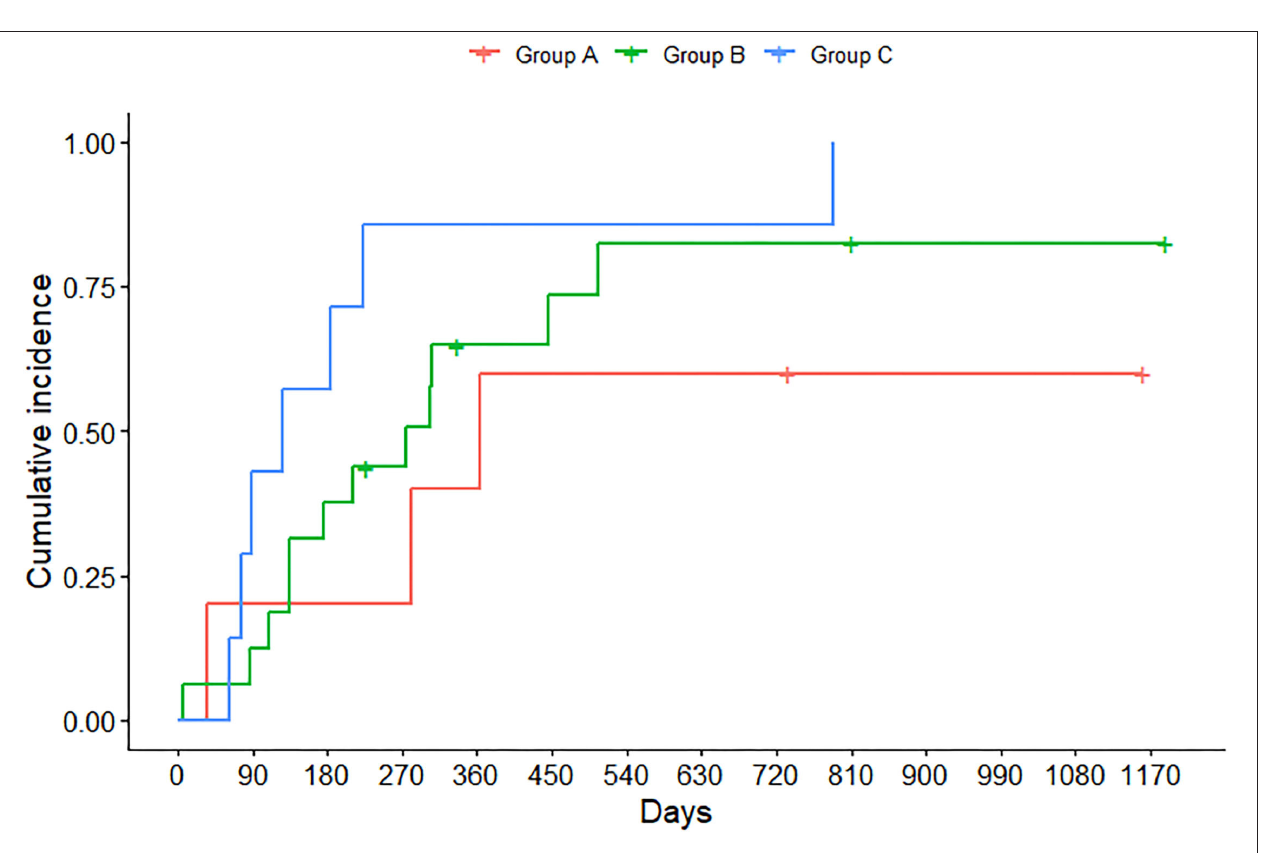
FIGURE 2 | Time at which children and adolescents experienced hospitalization due to pulmonary exacerbation (PE), stratified by FEV 1 z -score and LCI at 1/40th of starting concentration. Group A identifies individuals with FEV 1 ≥ LLN and LCI < ULN; group B individuals with FEV 1 ≥ LLN and LCI ≥ ULN, whereas group C individuals with FEV 1 < LLN and LCI ≥